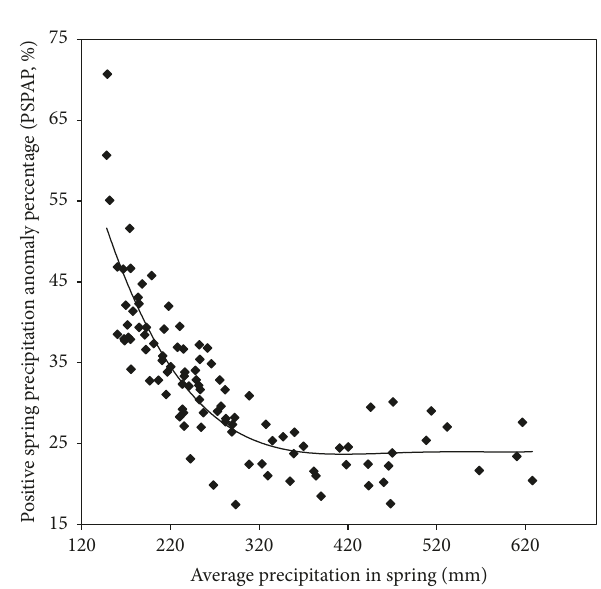
Figure 4: Relationship between the average PSPAP and the corre- sponding annual average precipitation for meteorological stations with winter wheat yield loss